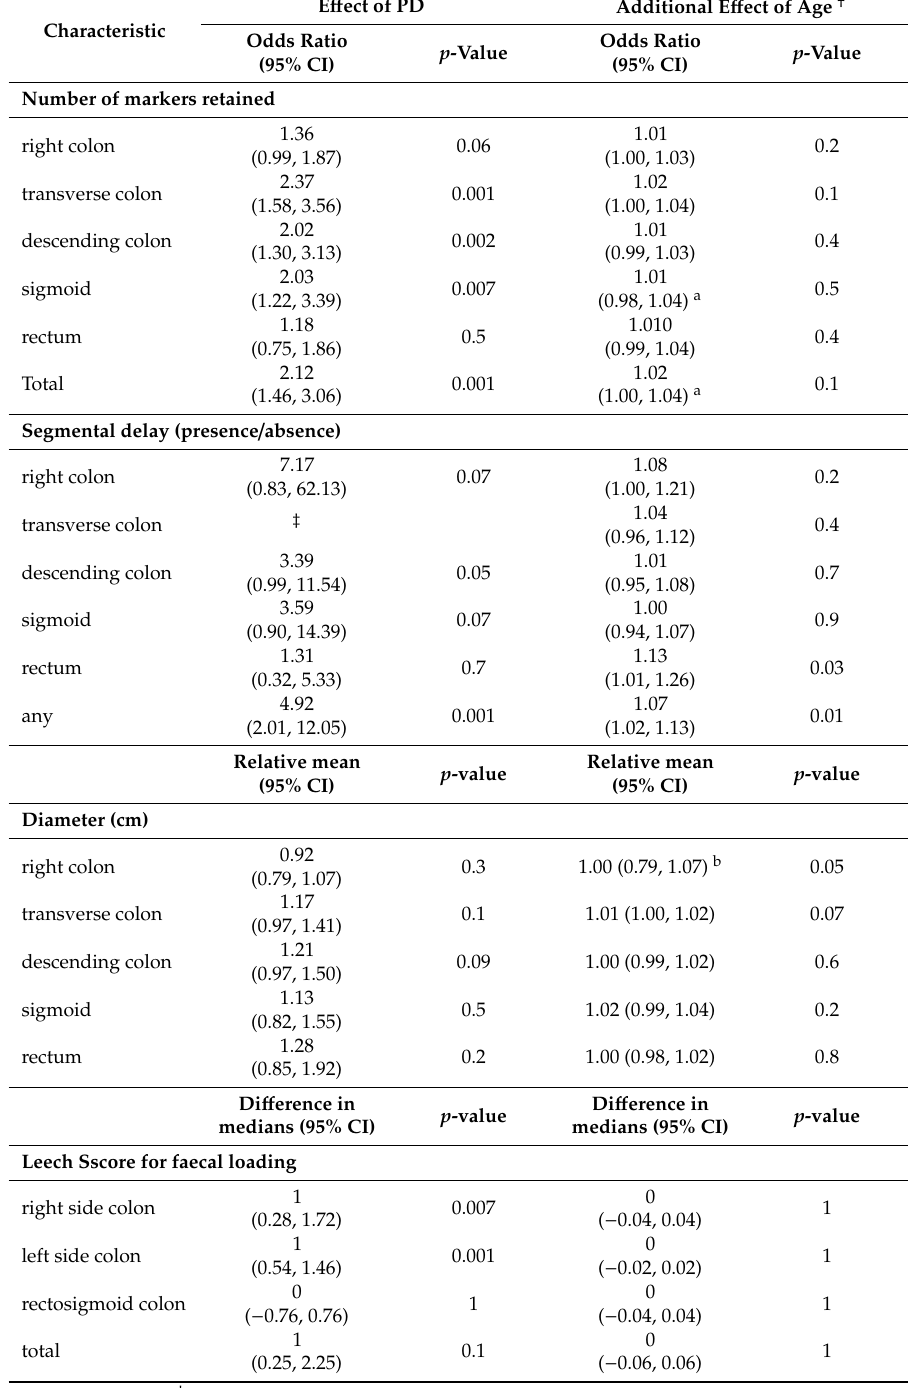
Table 2. Evaluation of the features of colonic transit time test X-rays, and the additional e ff ect of age, in predicting disease